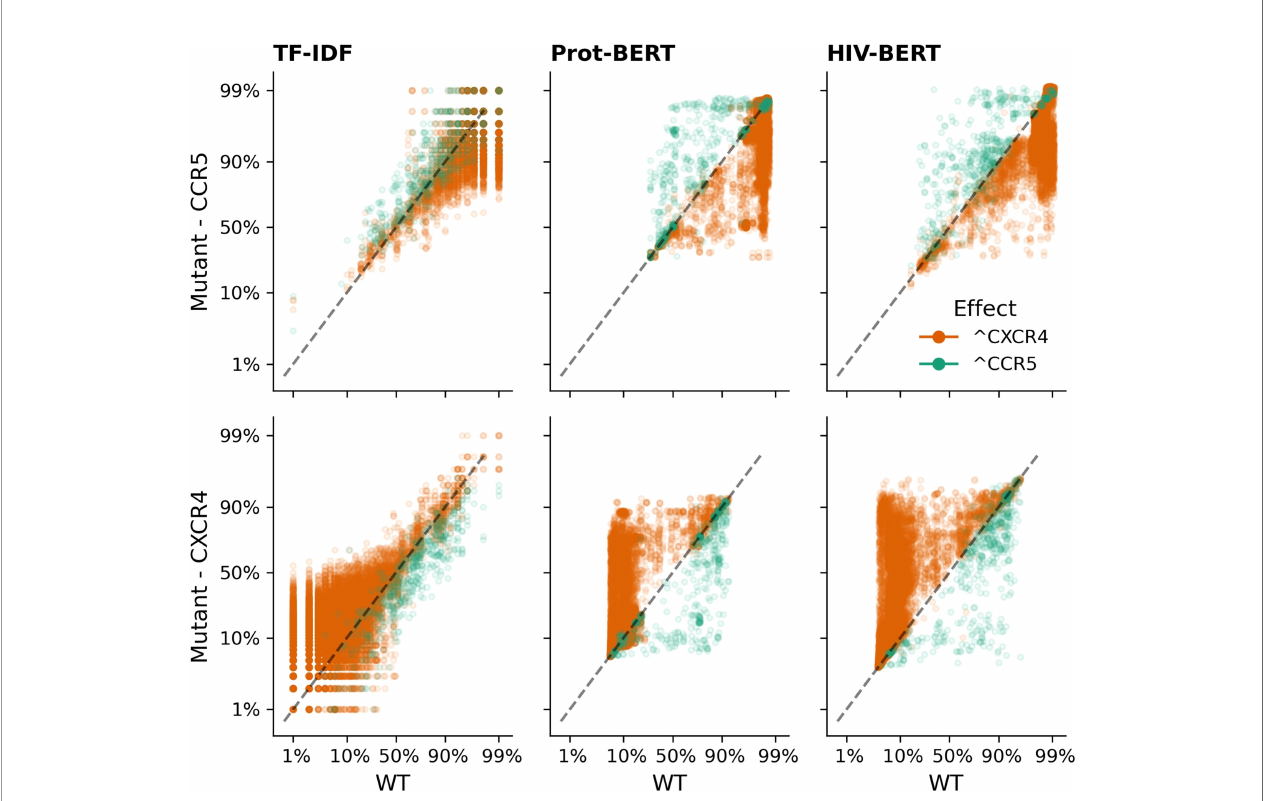
FIGURE 7 | Transformer models accurately predict the outcome of CXCR4 enhancing mutations. Each sequence in the V3 coreceptor dataset was mutated by each of the nine CXCR4 promoting mutations as described in the methods and each mutated sequence is shown as a single point; there are nine points per sequence. Sequences where a CXCR4 promoting mutation was added is shown in orange which should increase the probability of CXCR4 binding and decrease the probability of CCR5 binding. Points in green indicate sequences where a CXCR4 promoting mutation was removed and should decrease CXCR4 binding and increase CCR5 binding. The dashed black line shows the x=y line and the assumption of no change due to the mutation. Each column of axes shows the predictions using each of the three models with the fi rst column indicating the TF-IDF model; the second indicating the Prot-BERT model; and the third showing the HIV-BERT. Each row represents the prediction on a different coreceptor with CCR5 on the top and CXCR4 on the